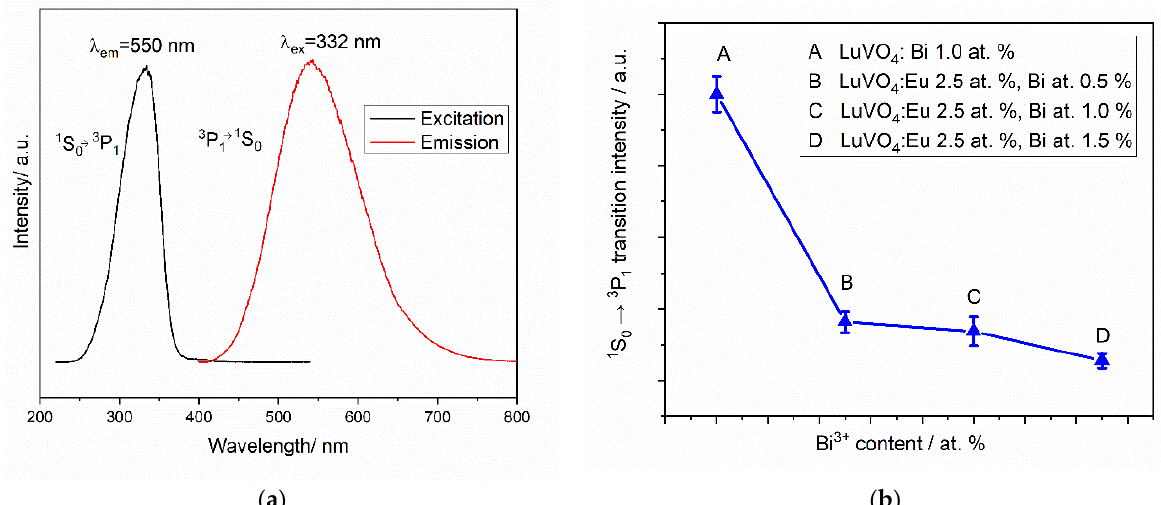
9 of 18 Figure 6. Excitation and emission spectra of LuVO 4 films with 2.5 at. % Eu 3+ and 1.5 at. % Bi 3+ after 3 h of annealing at 1000 °C. On the other hand, the luminescence properties of bismuth ions were analyzed. Fig- ure 7a presents the excitation and emission spectra of Bi 3+ for a mono-doped LuVO 4 : 1.0 at. % Bi 3+ film. As can be observed, congruent results are obtained when comparing with the observations of the co-doped sample, being the wavelength excitation at 332 nm and the greenish emission at 550 nm, products of the energy transition 1 S 0 → 3 P 1 for the excita-